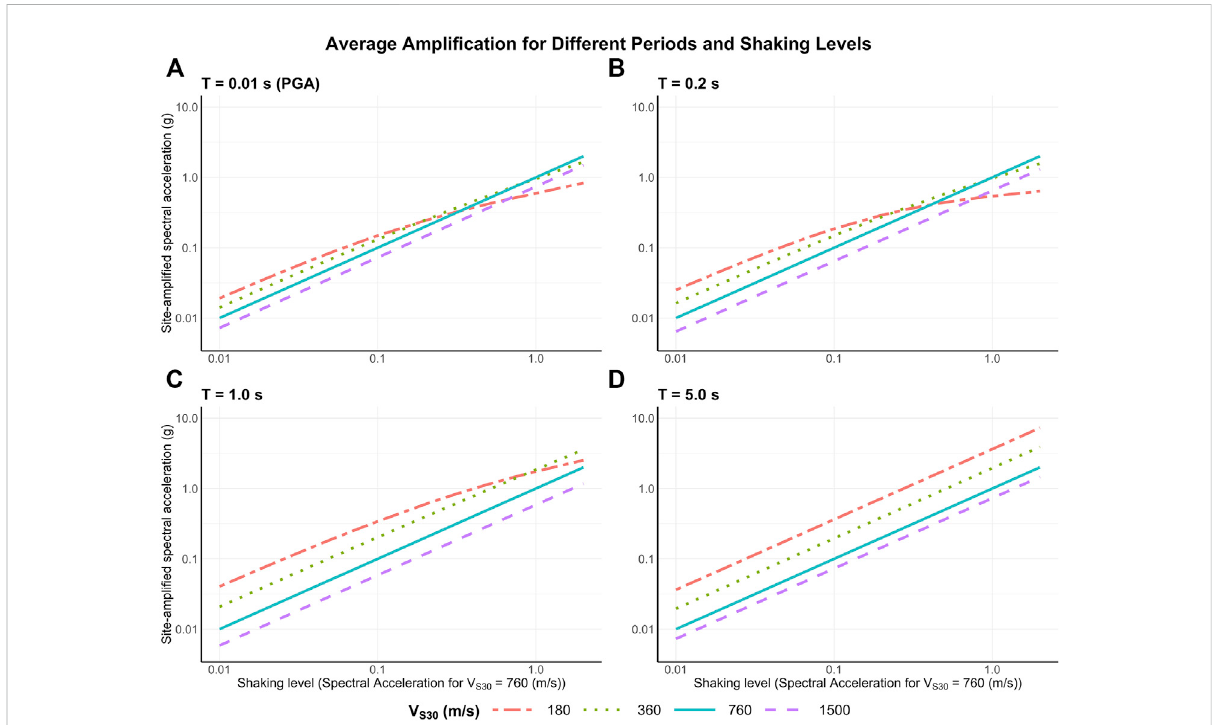
FIGURE 4 Ampli fi cation or deampli fi cation effects versus shaking level, given as spectral acceleration for V S30 = 760 m/s, for various periods (A) T = 0.01 s (PGA), (B) T=0.2s, (C) T=1.0sand (D) T=5.0s.In (A) ,linearampli fi cationarisesforweakshakingandnonlineardeampli fi cationforstrongshaking.In (D) , linear ampli fi cation arises for all shaking. For all periods, no ampli fi cation or deampli fi cation occurs when V S30 = 760 m/s, as shown by the solid, 1-1line.ForV S30 > 760 m/s, deampli fi cation islinear (purpledashed line).Linearampli fi cationarises forV S30 < 760withlong-periodshaking, for e.g., (D) . Nonlinear deampli fi cation arises for V S30 < 760 m/s, with strong, short-period shaking (e.g.,